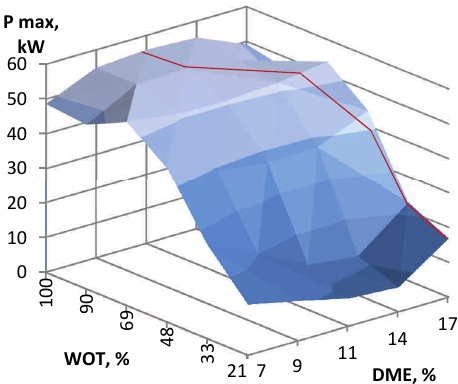
Fig. 6. Values of engine maximum power in depend of DME share & engine load, λ = 1.0